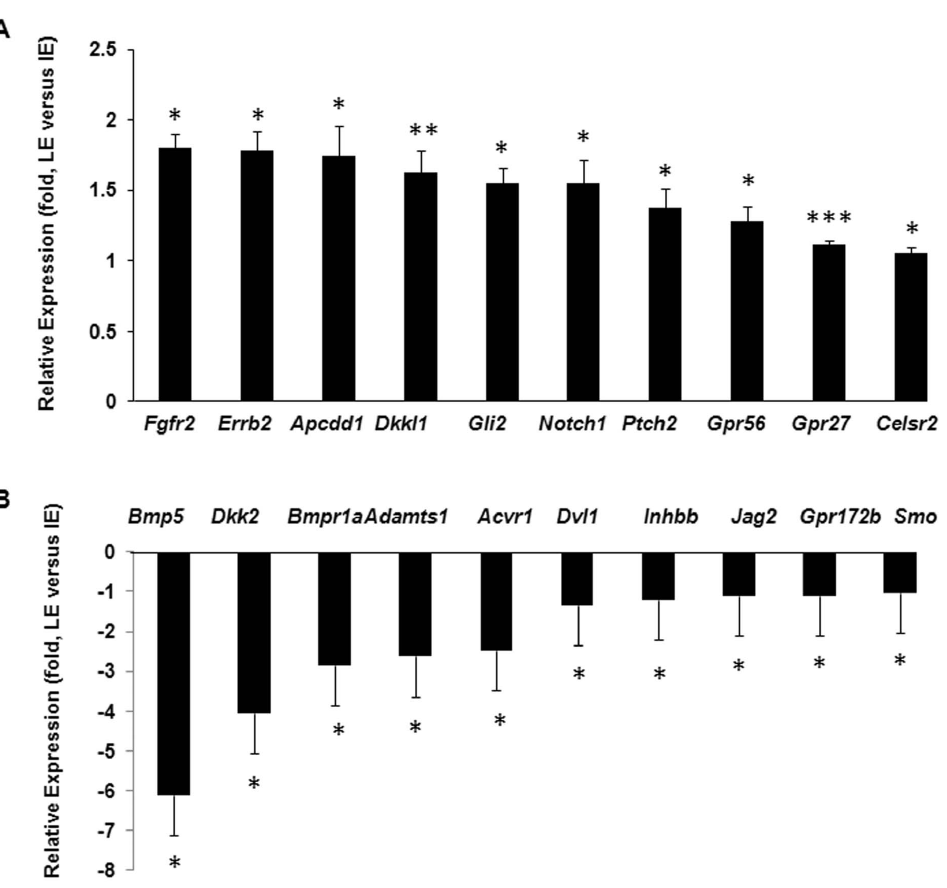
Figure 1. Summary of the microarray analyses. Genes differentially expressed in LE and IE cells. Statistical significant differential gene expression between LE and IE samples were summarized in (A) genes expressed more in LE than IE cells, and (B) genes expressed less in LE than IE cells. * p , 0.05, **p , 0.01 and ***p , 0.001 are considered significant.